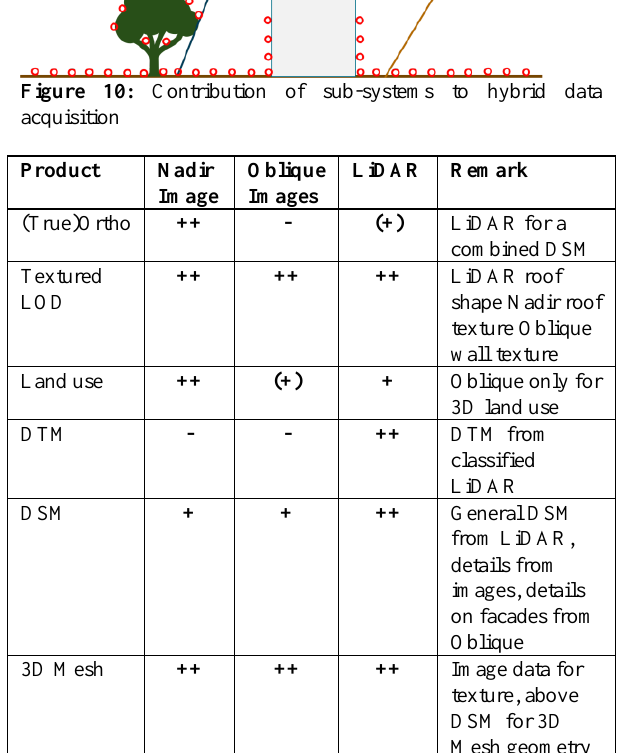
Table 3: Contribution of dataset to final product, ++ strong, + minor, - no contribution